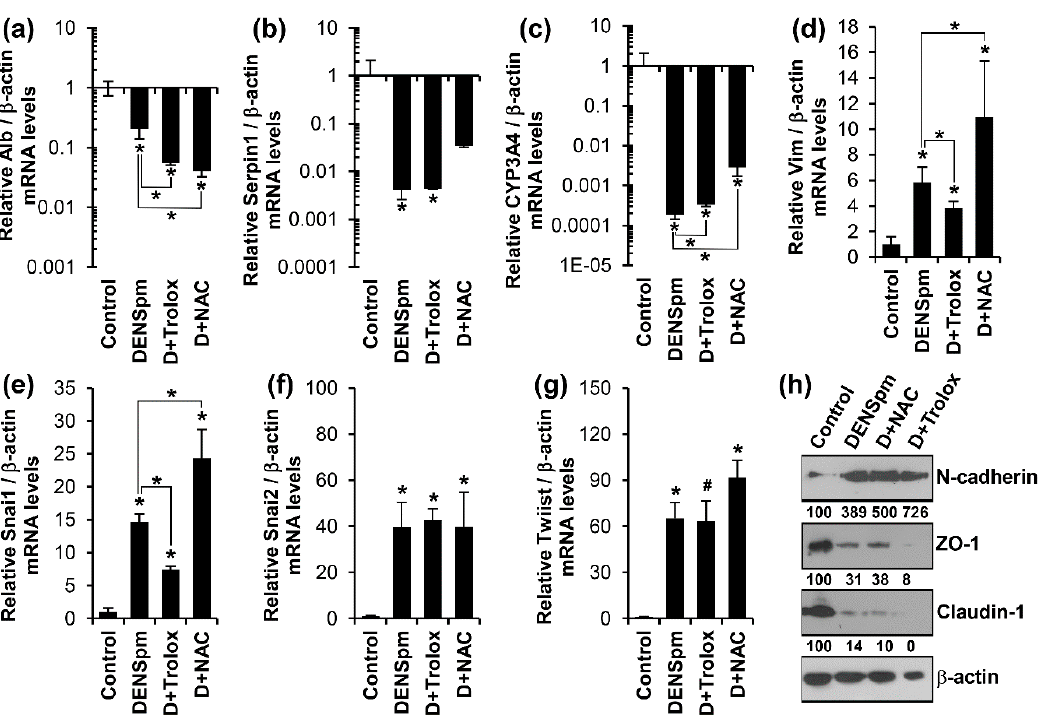
Figure 4. DENSpm-triggered deddifferentiation is not mediated by reactive oxygen